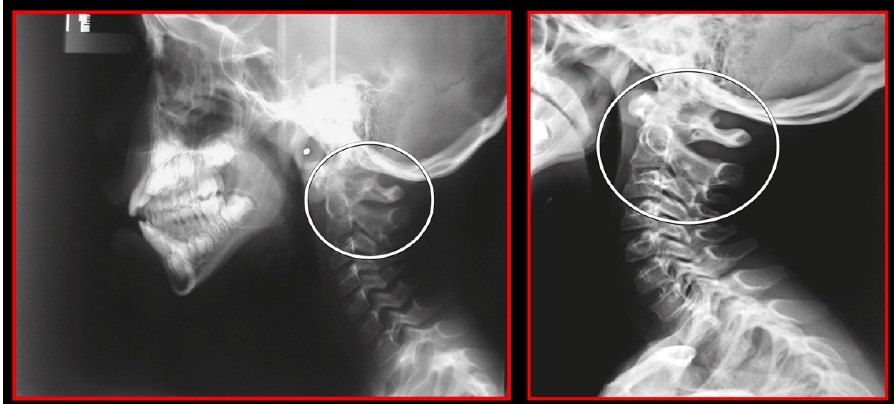
Figure 9. Rotation of the atlas on a lateral cephalometric radiograph. Left: Pre-treatment. Double ring of the atlas showing its rotation. Decreased functional spaces. Right: After orthopedic manual therapy. Only one posterior arch of the atlas showing the normalization of its rotation. Normalized functional spaces.